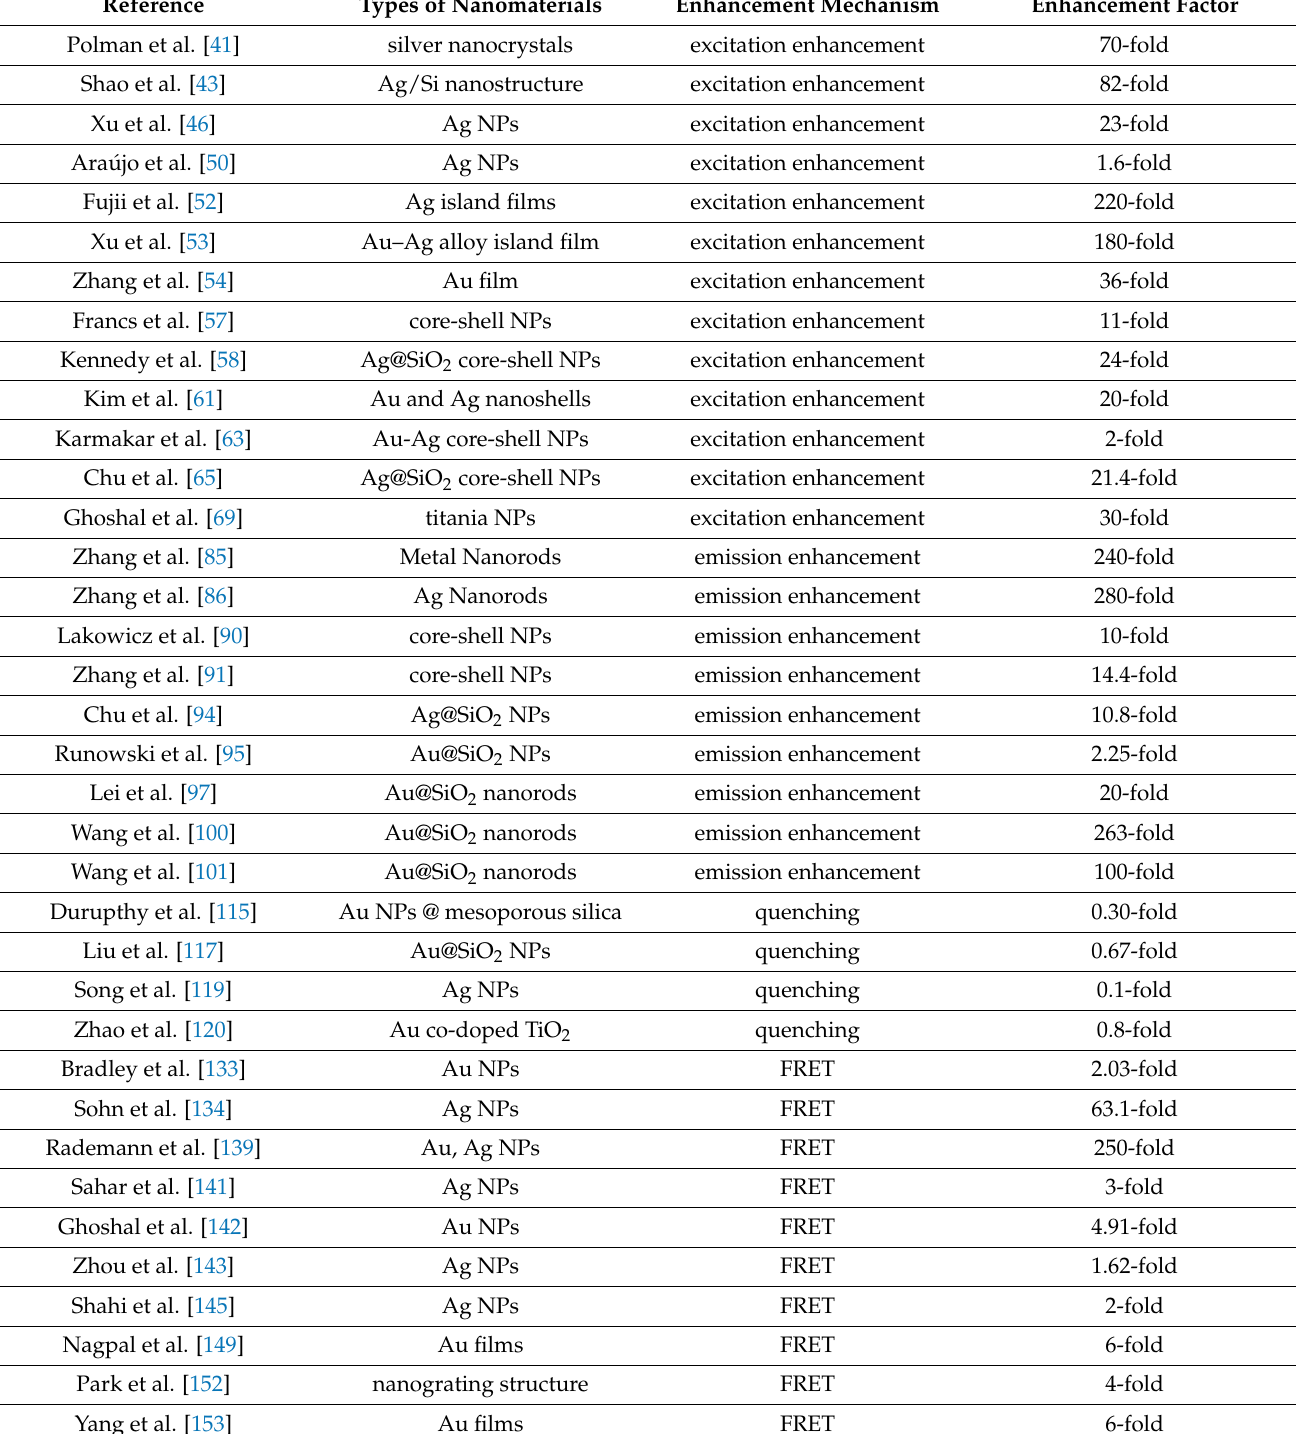
Table 1. Enhancement mechanisms and luminescence enhancement